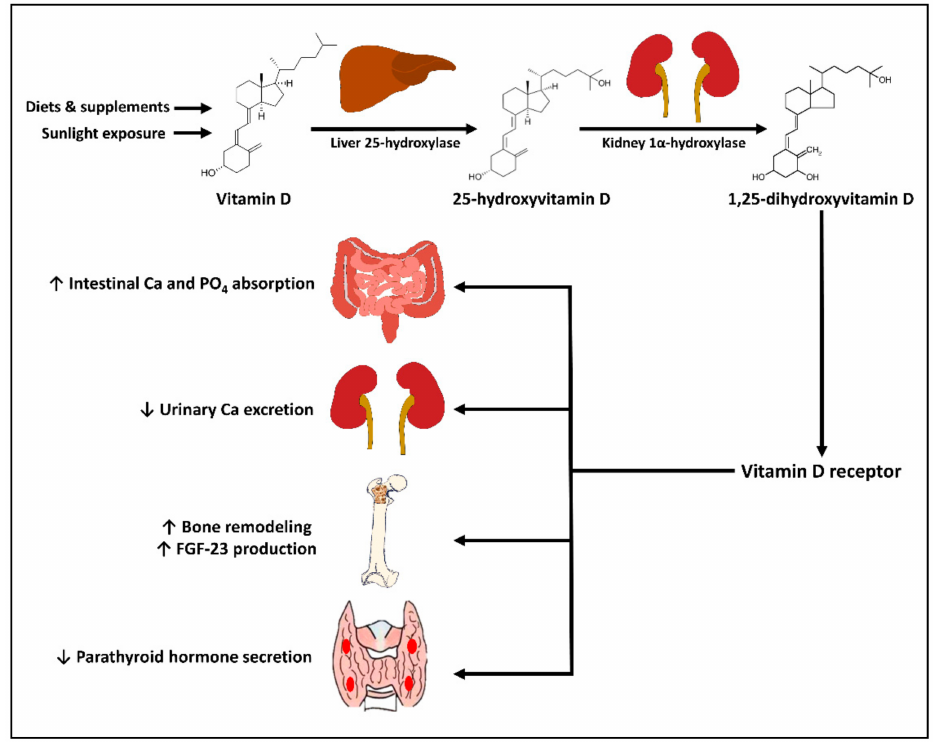
Figure 1. Schematic representation of the synthesis, sources, and metabolism of vitamin D for skeletal function. ↑ : Increased; ↓ : Decreased; Ca: Calcium; FGF-23: fibroblast growth factor-23; PO 4 :